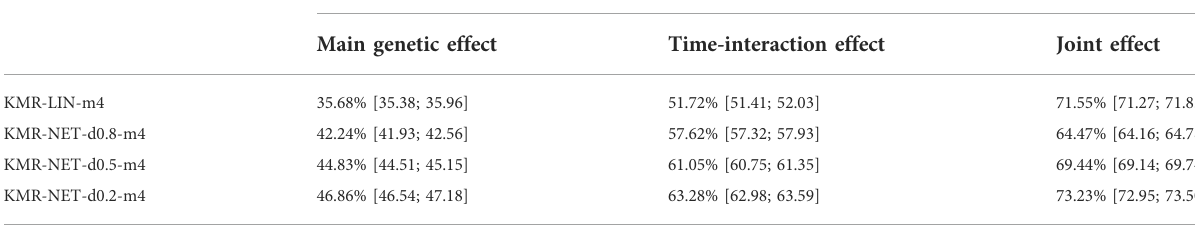
TABLE 5 Power comparison for main, time-interaction and joint effects.